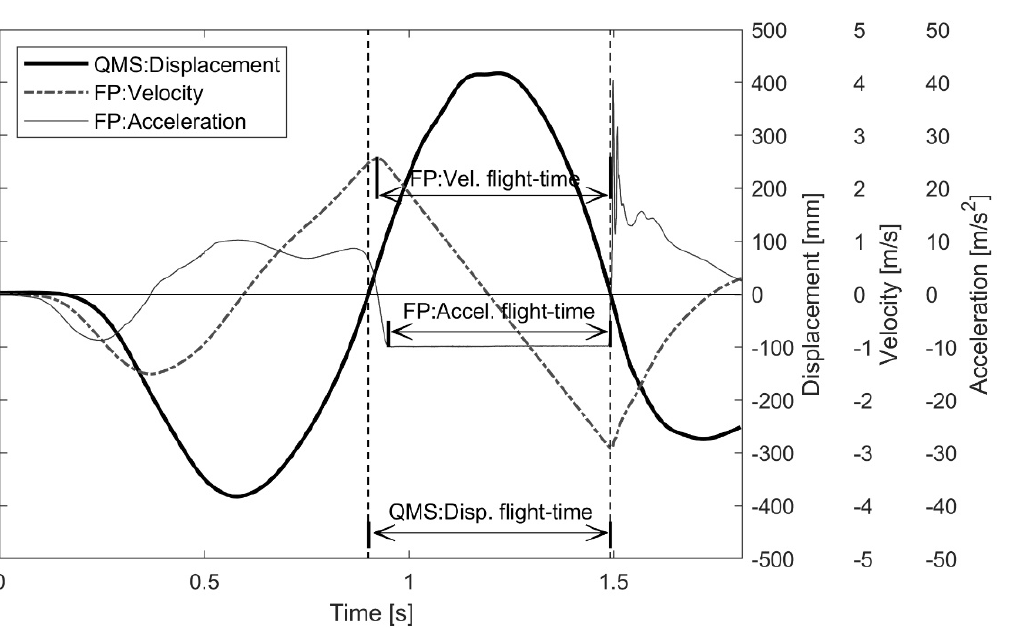
Figure 5. The vertical position, velocity, and acceleration were recorded during the jump, with the indication of flight-time.